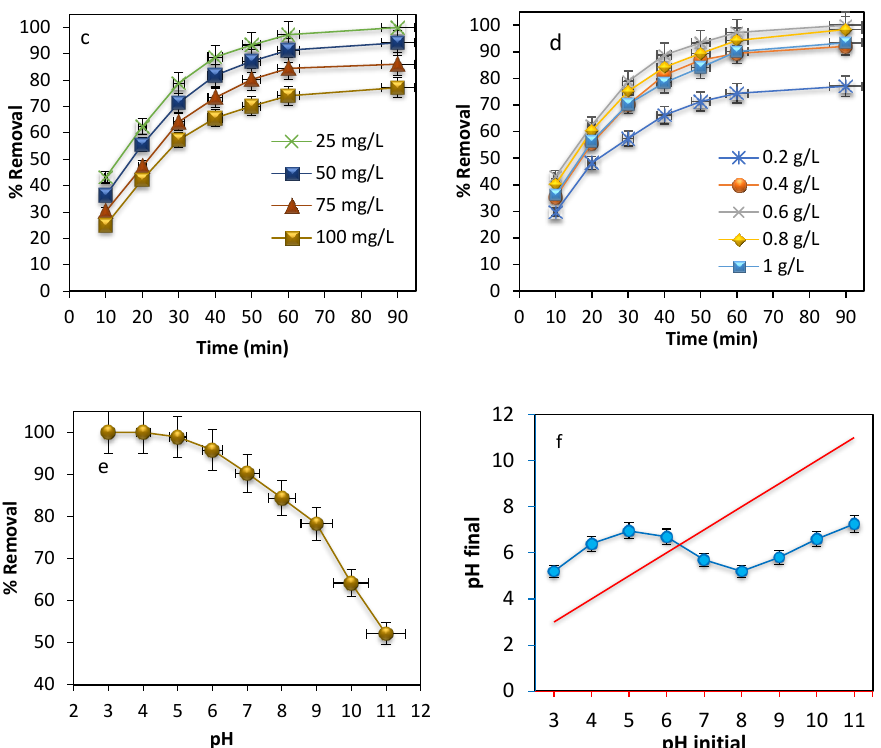
Figure 4. Comparison of RR198 degradation by UV light ( a ), Comparison of RR198 degradation by Visible light ( b ), Effects of RR198 concentration ( c ), Effects of Fe 2 O 3 /B/TiO 2 dosage ( d ), Effects of solution pH ( e ), Determination of the pH pzc ( f ).